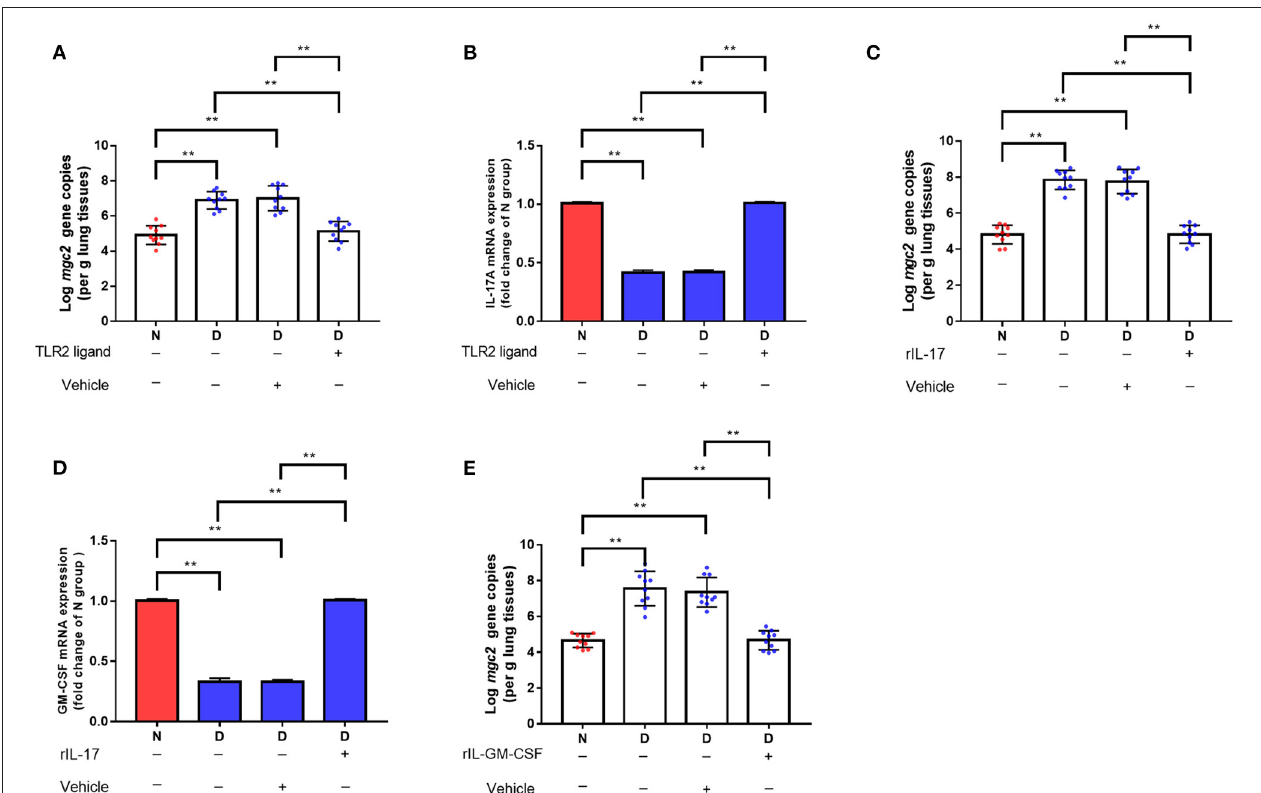
FIGURE 4 | The effects of TLR2, TL-17, and GM-CSF on MG colonization in lung of gut microbiota dysbiosis group. (A) Mgc2 gene copies in chicken lung after TLR2 ligand administration and MG infection ( n = 10). (B) IL-17 mRNA expression levels in chicken lung after TLR2 ligand administration and MG infection ( n = 6). (C) Mgc2 gene copies in the chicken lung after rIL17 administration and MG infection ( n = 10). (D) GM-CSF mRNA expression levels in chicken lung after rIL17 administration and MG infection ( n = 6). (E) Mgc2 gene copies in chicken lung after rGM-CSF administration and MG infection ( n = 10). Indicated groups were intranasally administered TLR2 ligand (P3C, 50 µ g) or 0.05 µ g rIL17 or 0.05 µ g rGM-CSF 1h prior to MG infection at indicated dates showed in Figure 1 . Values were expressed as means ± SD. **Indicates P <